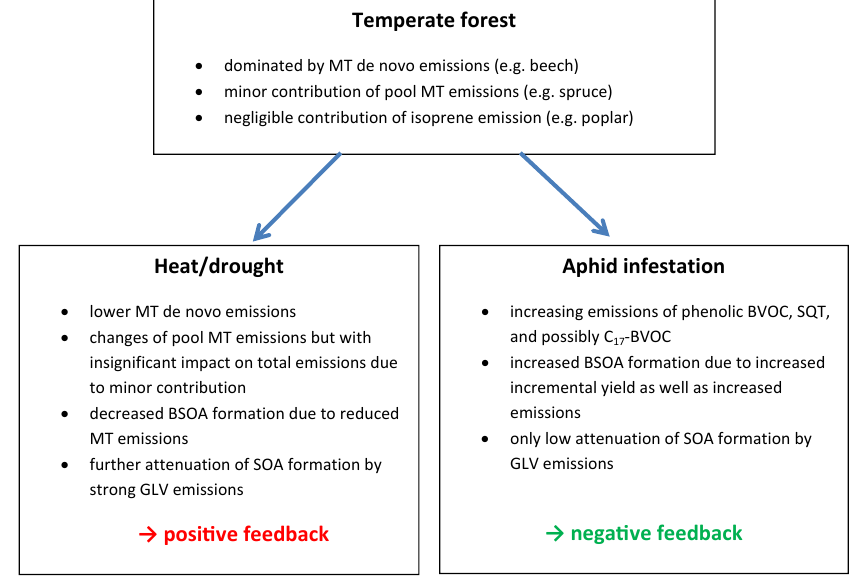
Fig. 9. Examples of estimated climate feedbacks of stress to temperate forests. Under negative feedback we understand that enhanced BSOA formation and related direct and indirect effects counteract heat and drought. In case of positive feedback the reduced BSOA formation enhances effects of heat and drought. For biotic stress we refer to the case of heat and drought increasing the chance of pathogen and herbivore